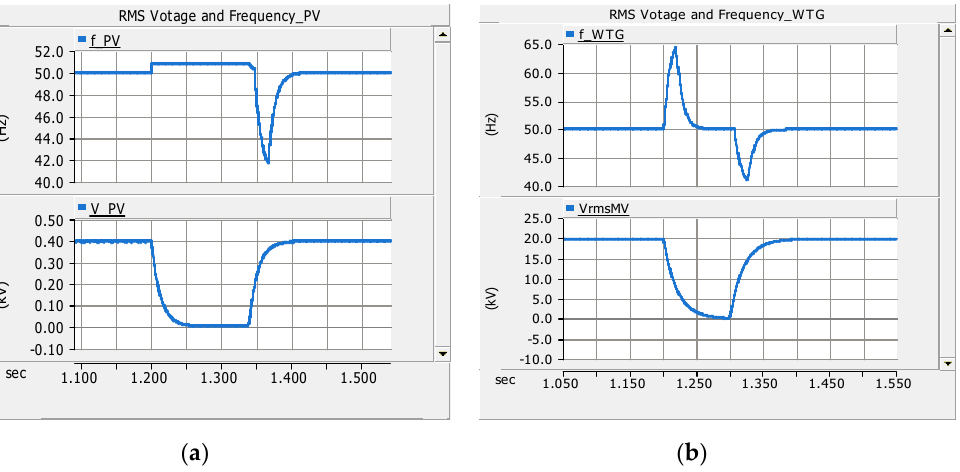
Figure 22. Three-phase RMS voltage and the frequency of DGs before, during and after fault F2 in islanded mode at: ( a ) the LV side of the PV system and ( b ) MV side of the WTG.